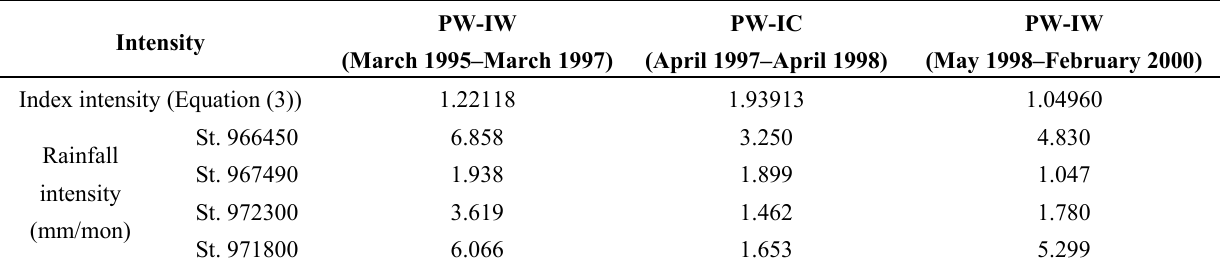
Table 2. Monthly-mean rainfall intensities at the weather stations in central Indonesia and the index intensities during the three synoptic cases defined in this study. The index intensities are period-averaged, and the stations 971800 and 972300 are located along the pathway of the ITF. PW-IW PW-IC Intensity (March 1995–March 1997)